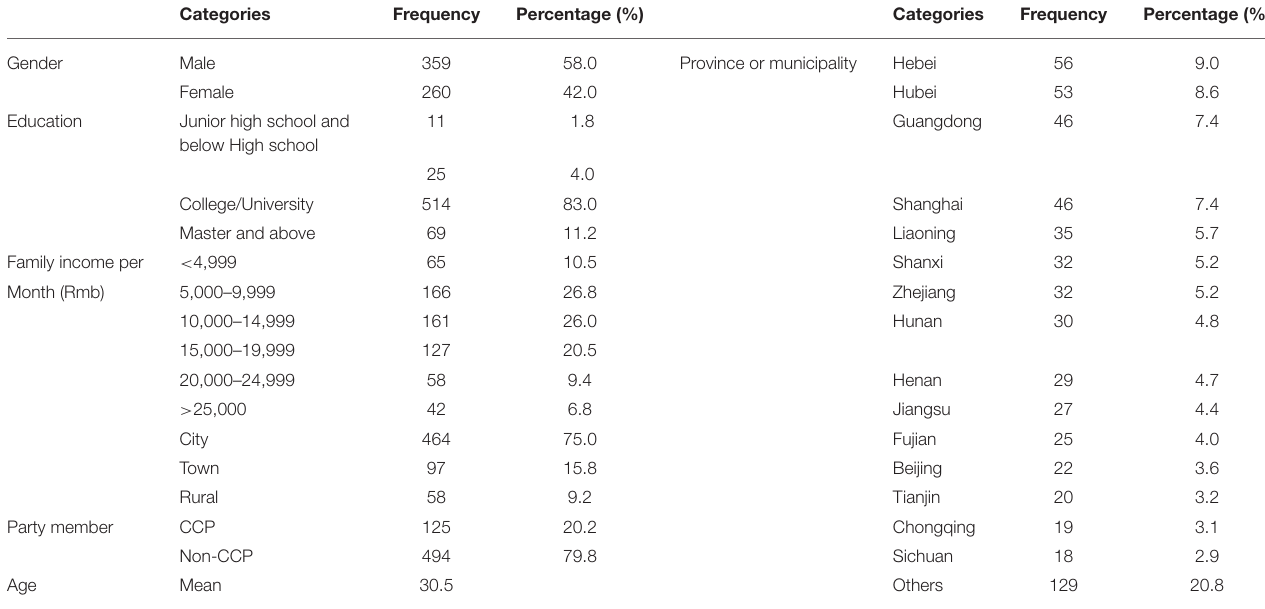
TABLE 1 | Distribution of sample socio-demographics.